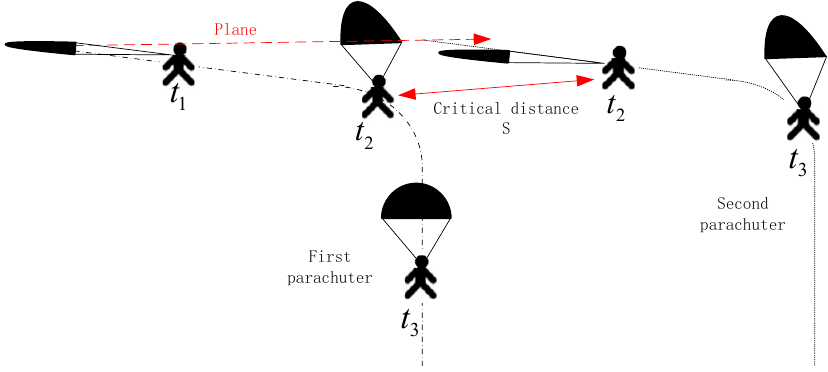
Figure 11. Relative locations of adjacent parachute systems at different moments.